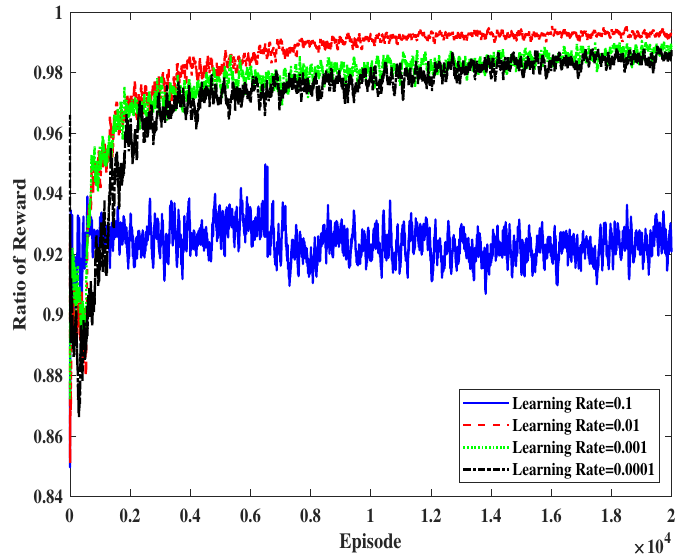
Figure 4. Convergence of performance over different learning rate